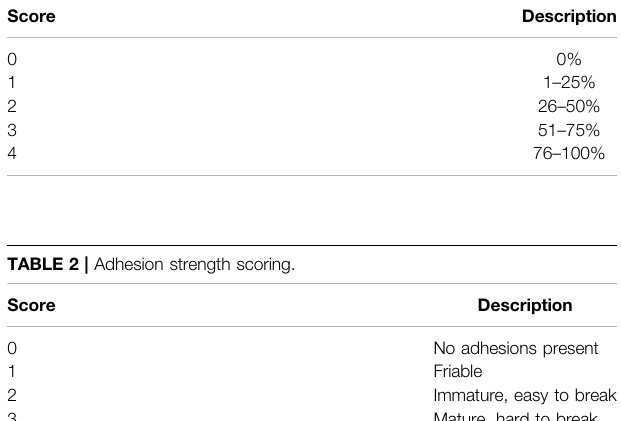
TABLE 1 | Adhesion extent scoring (% of defect).